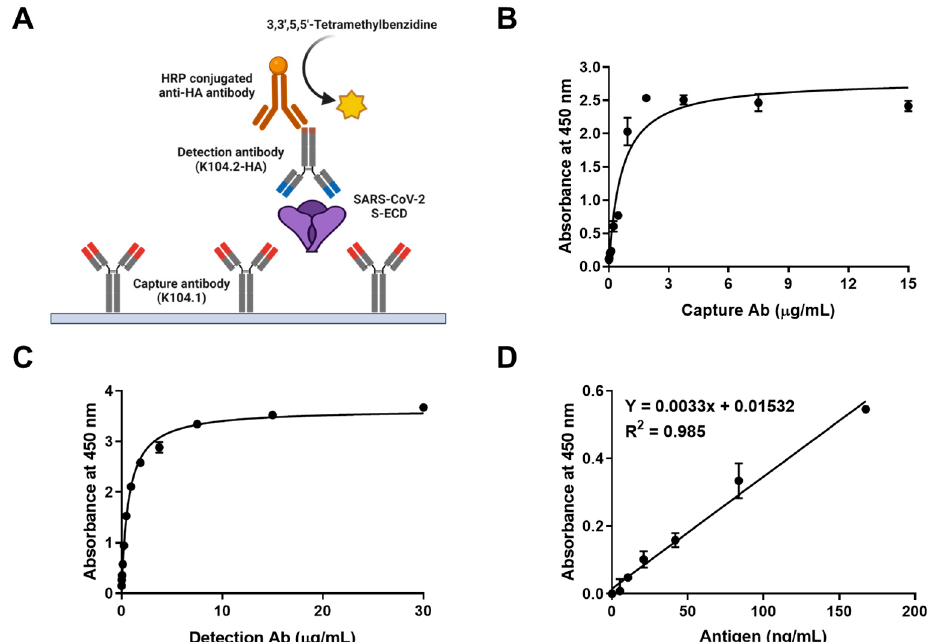
Figure 4. Development and characterization of SARS-CoV-2 spike protein-specific sandwich immunoassay. ( A ) Schematic representation of the sandwich immunoassay. ( B ) Optimization of the capture antibody (K104.1) concentration using the sandwich immunoassay. Microplate wells were coated with varying concentrations of K104.1, followed by incubation of the plates with 0.1 μ g of SARS-CoV-2 S-ECD and 5 μ g/mL of detection antibody (K104.2-HA). ( C ) 3.75 μ g/mL of K104.1 was coated onto a microplate and incubated with 0.1 μ g of SARS-CoV-2 S-ECD. The optimum concentration of the detection antibody (K104.2-HA) was determined using sandwich immunoassay titration with varying concentrations of K104.2-HA. ( D ) SARS-CoV-2 S-ECD calibration curve to determine the limit of detection (LOD) was constructed using 1.875 μ g/mL of K104.1 and 3.75 μ g/mL of K104.2-HA. All values represent mean ± SD of triplicate measurements from one out of the six independent experiments.